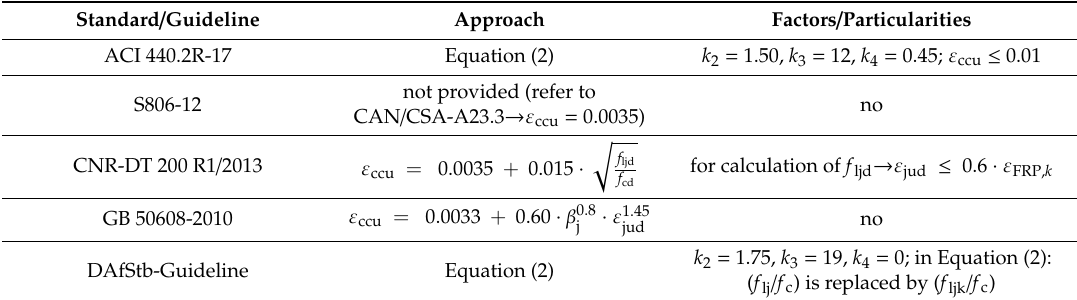
Table 6. Approaches suggested in codes and guidelines to predict the maximum concrete strain.